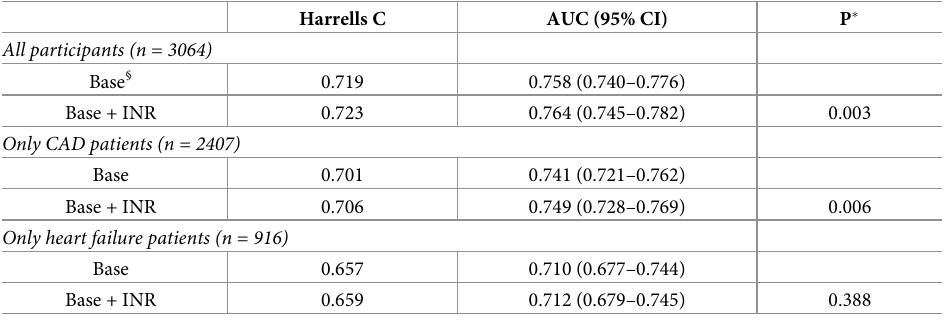
Table 4. Risk prediction models with and without inclusion of the